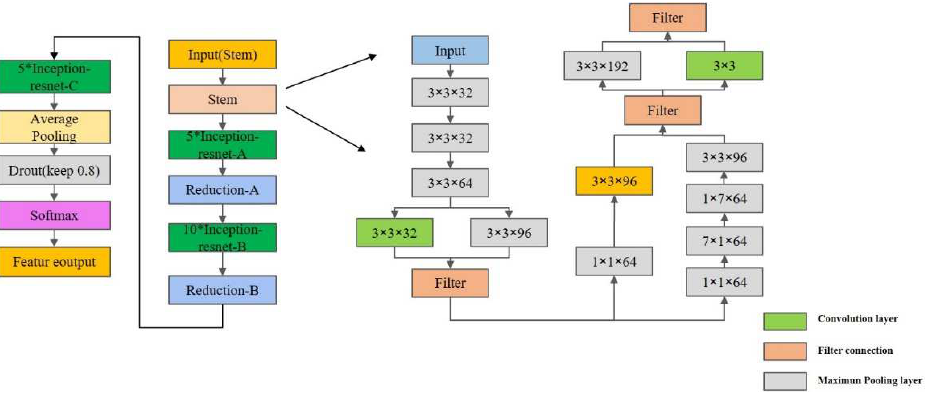
Figure 4. Inception ResNet V2.